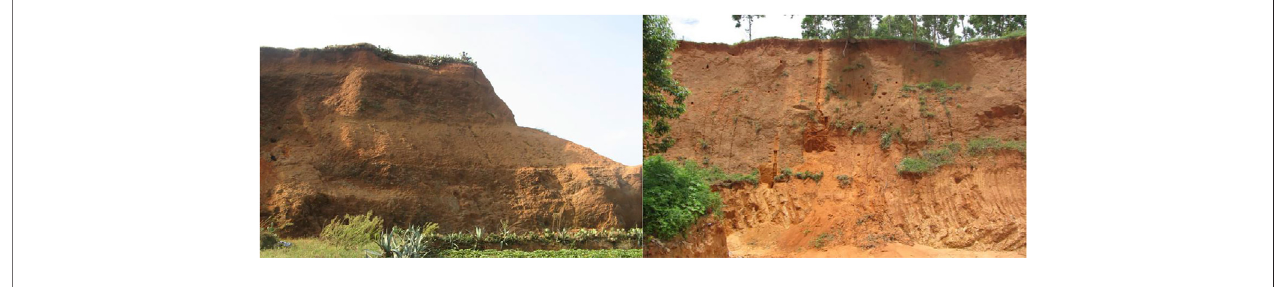
FIGURE 2 | The Old Red Sand in Pingtan island, Fujian Province.